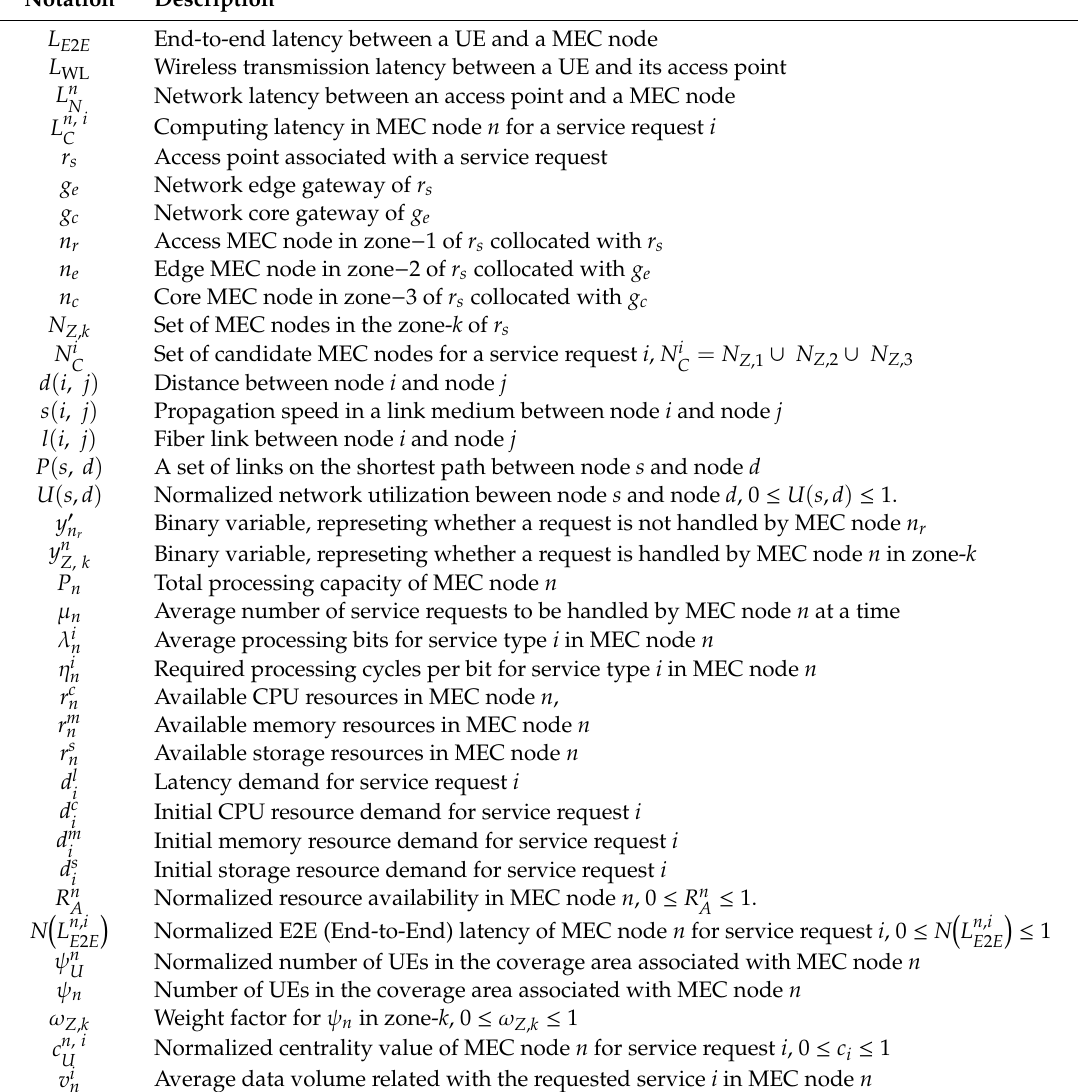
Table 2. Summary of notations. UE, user equipment; CPU, central processing